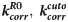
Mean values and standard deviation of stiffness values kR0, kcuto, kcorrR0,kcorrcuto and knimble.Values are shown for each location separated by subjects. Significant difference between locations measured by each device are indicated. Significance level are indicated as **p < 0.01 and *** p < 0.001.